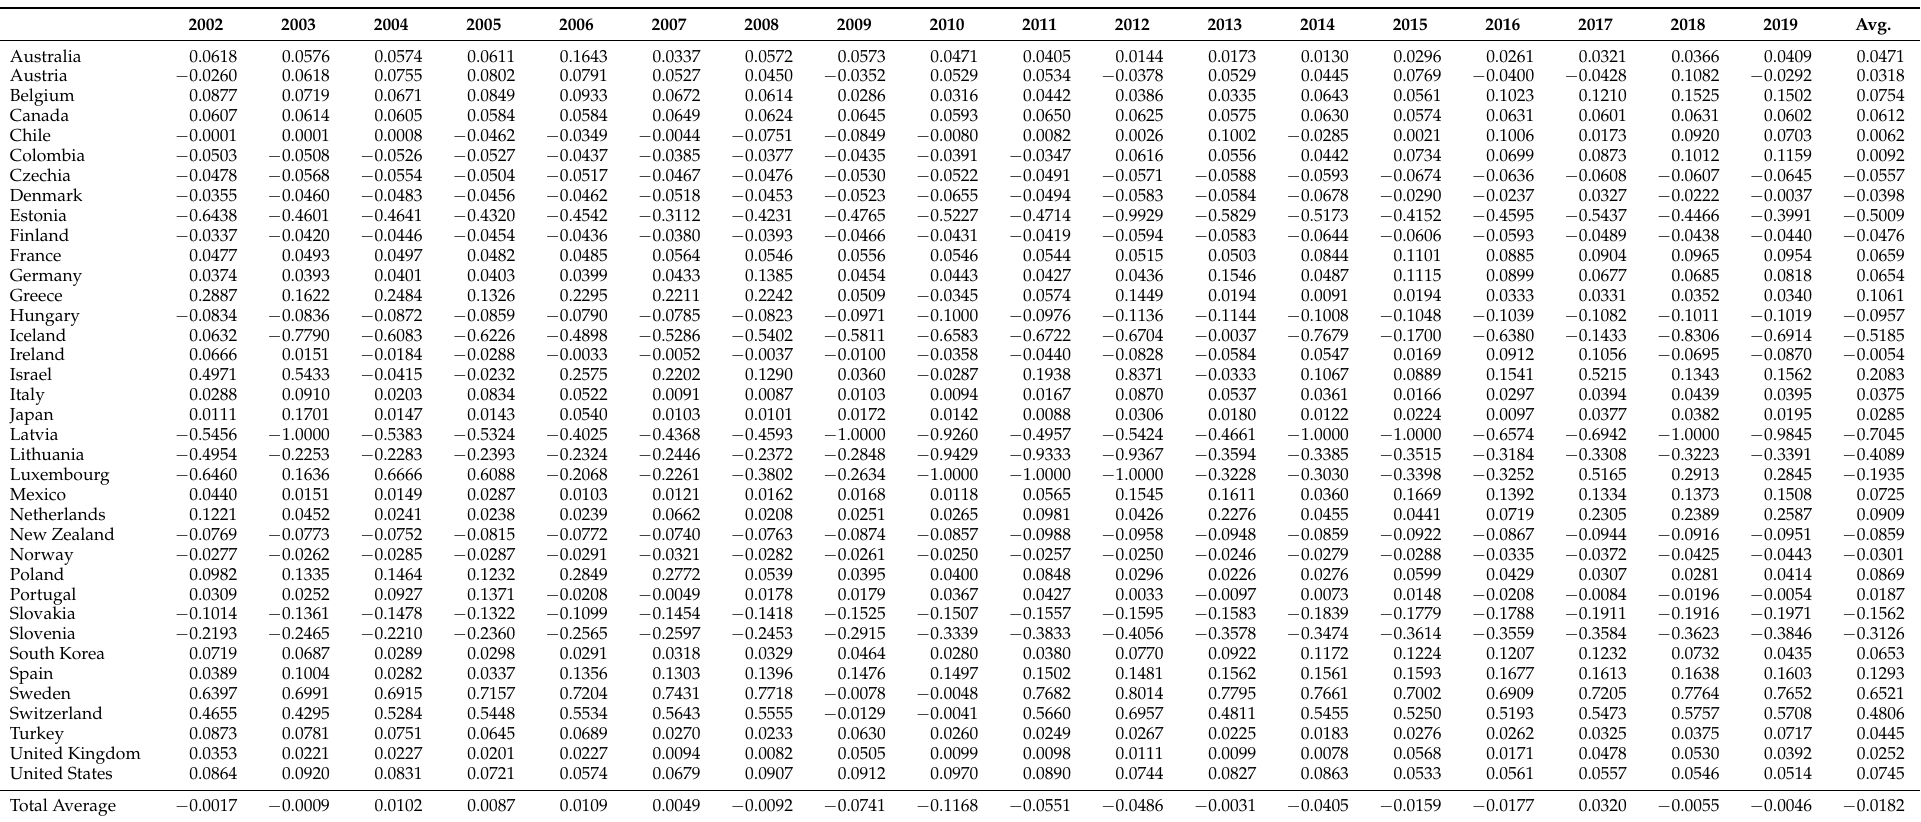
Table 8. Intercepts ( σ ∗ t ) for measuring RTS of OECD